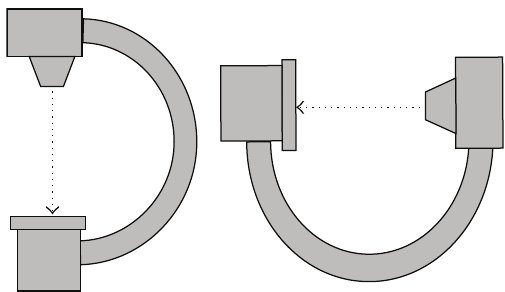
Figure 2: Typical C-arm fluoroscope found in hospitals. Biplane images are obtained by rotating the C-arm at two perpendicular positions, whereas monoplane images are acquires at a specific C- arm